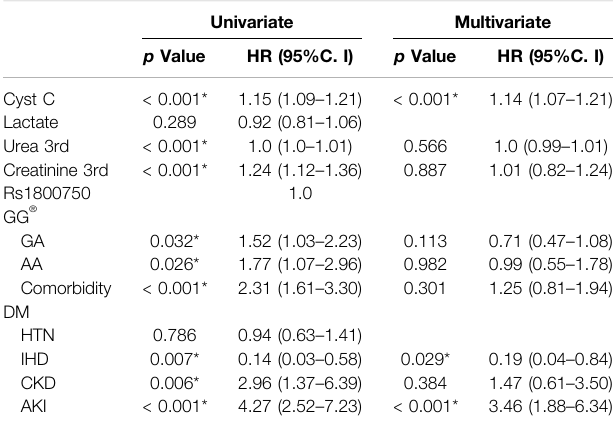
TABLE 6 | Univariate and multivariate COX regression analysis for overall survival for different parameters in all patients (No. (cid:1) 200). Univariate